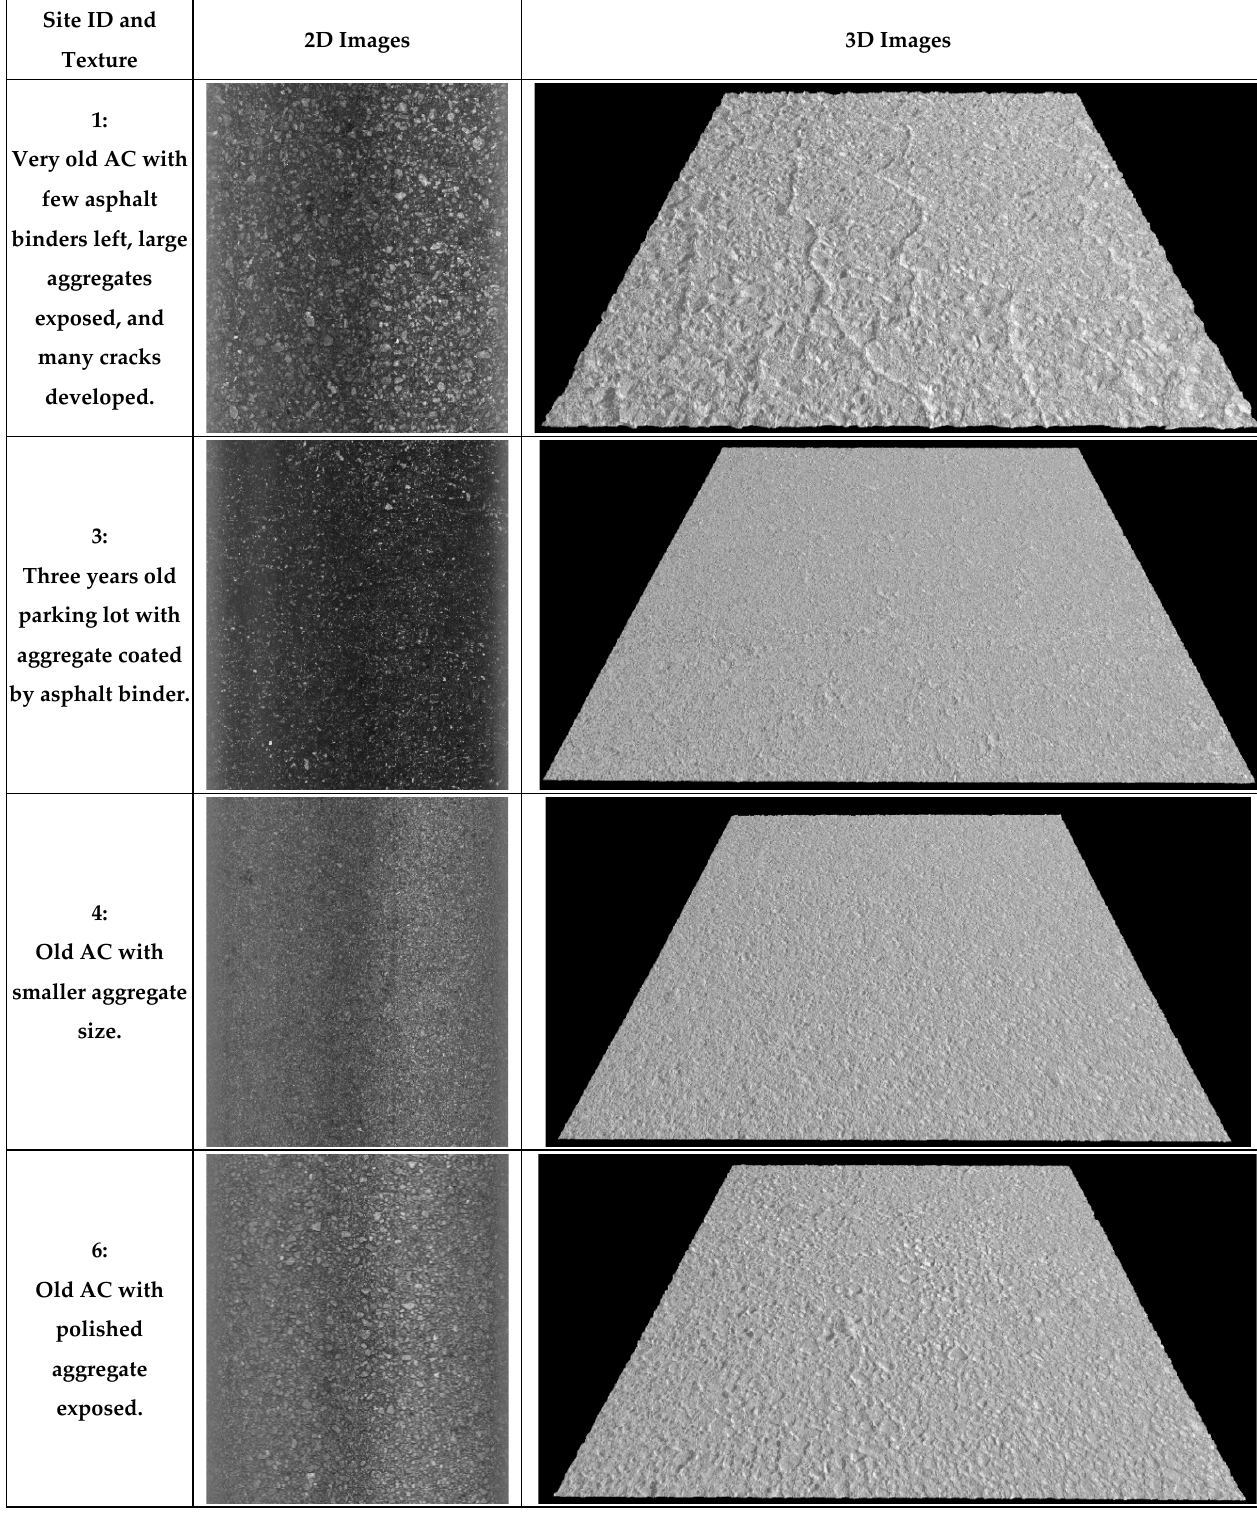
Figure 3. Example 0.1 mm images on AC sites.